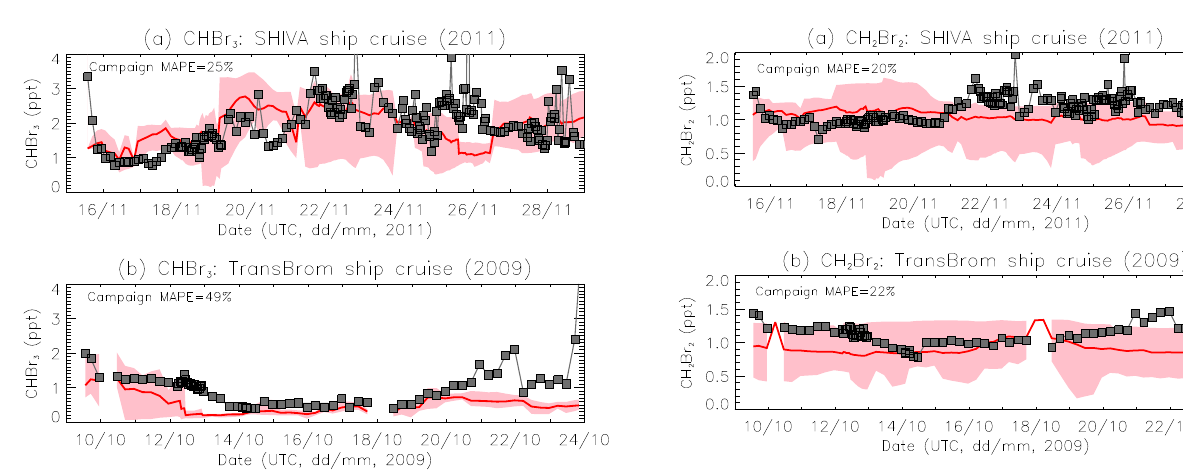
Figure 8. Comparison of modelled vs. observed CHBr 3 surface vol- ume mixing ratio (ppt) during (a) SHIVA (2011) and (b) Trans- Brom (2009) ship cruises. The multi-model mean is shown and the shaded region is the model spread. The mean absolute percentage error (MAPE) over each campaign is annotated.